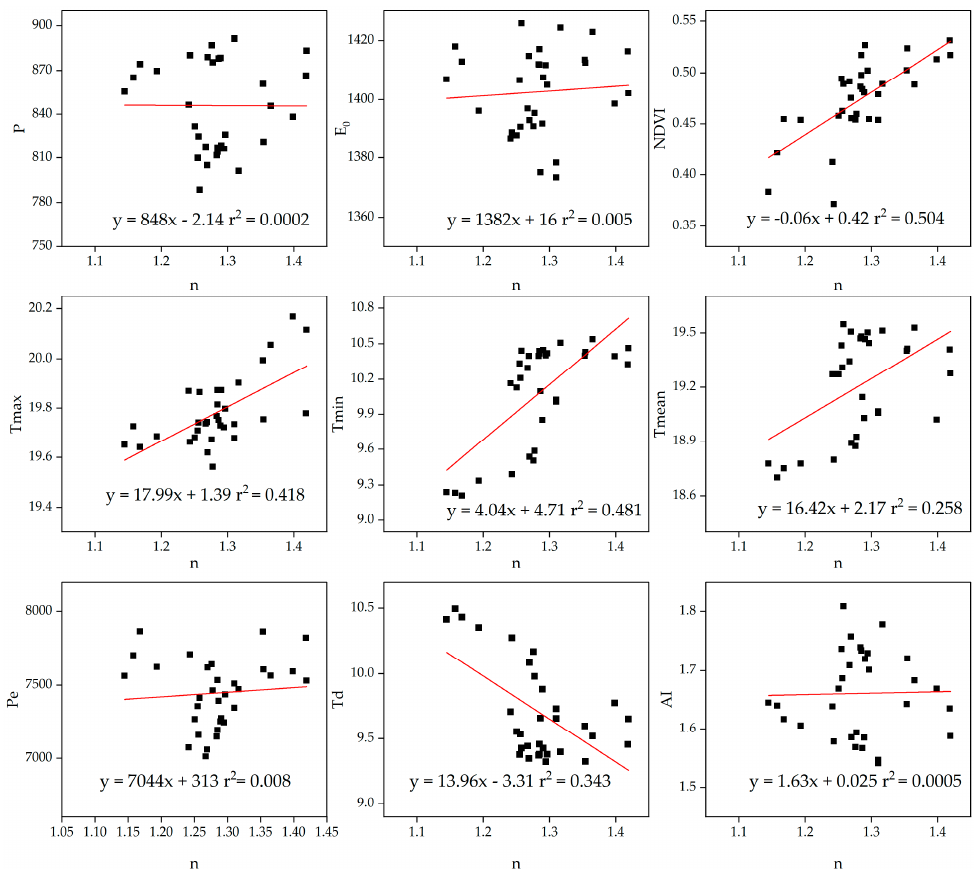
Figure 4. Correlation between climate change and ecological restoration on underlying surface factor ( n ): precipitation ( P ), potential evapotranspiration ( E 0 ), maximum air temperature (Tmax), minimum air temperature (Tmin), mean air temperature (Tmean), temperature difference (Td), precipitation erosivity (Pe) and aridity index (AI). The red line is the correlation trend of each factor and n value of the year, and the black box is the corresponding n value of each factor of the year.